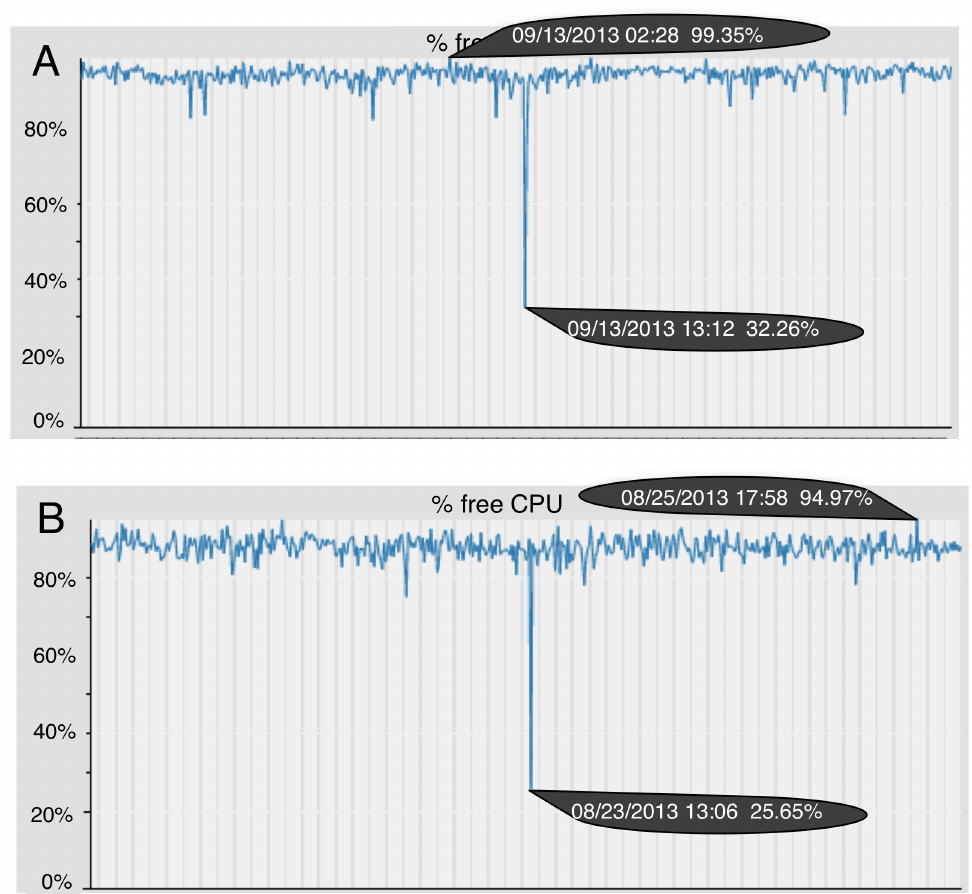
Comparison of the percentage of free CPU: ( A ) the period of the module implementation (11 to 15 September 2013); ( B ) the period preceding the implementation (21 to 25 August